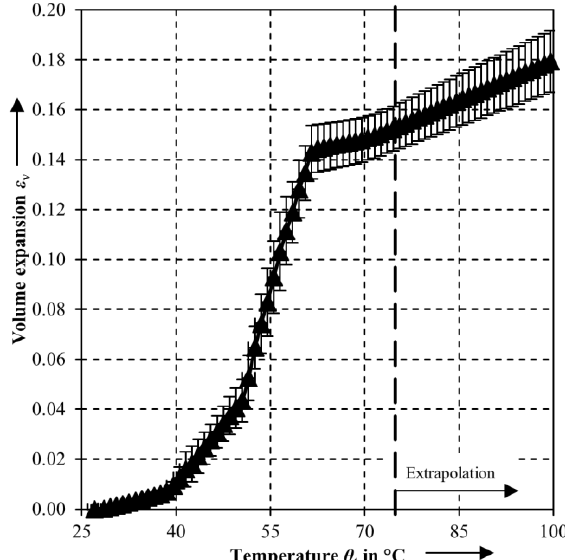
Figure 3. Recorded volume expansion data.